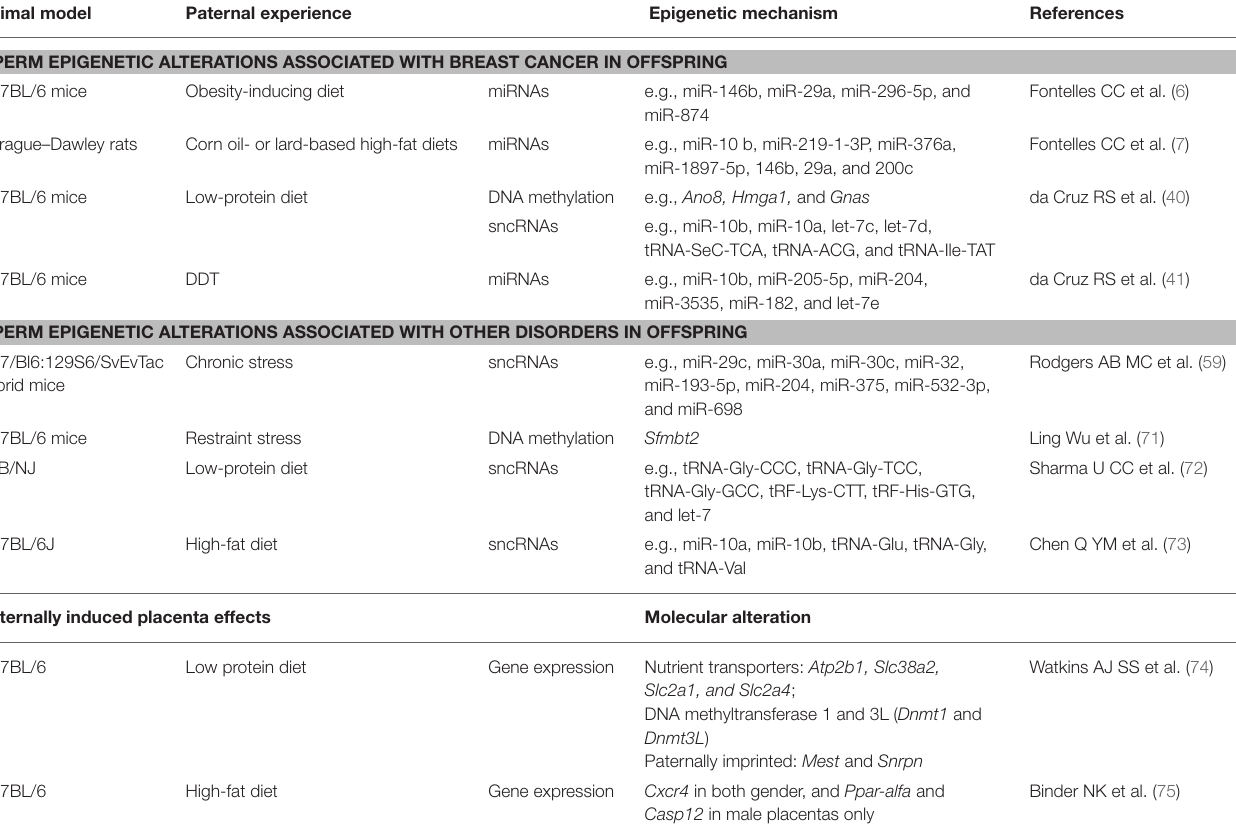
TABLE 2 | Summary of epigenetic and molecular alterations in male germline and in placenta linked to paternal environmental exposures. Animal